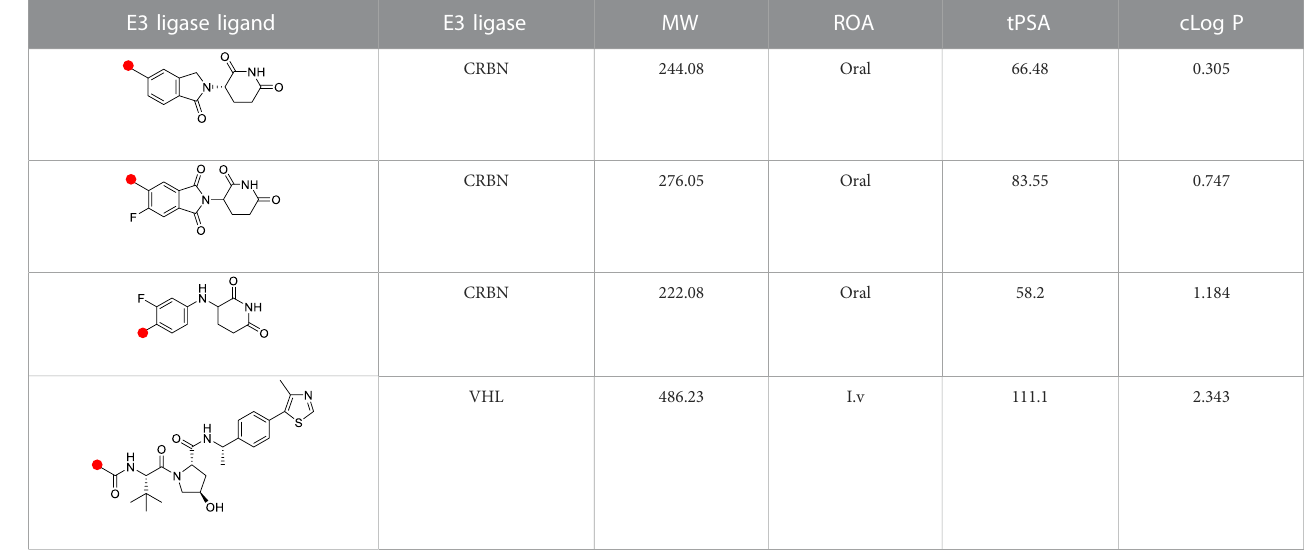
TABLE 2 Summary of the chemical properties of E3 ligase ligands in clinical trials. E3 ligase